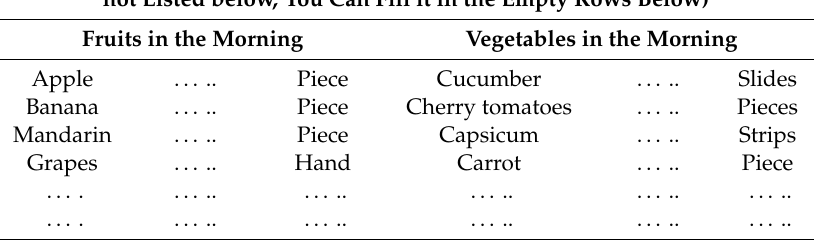
Table 2. One of the precoded questions on FV intake in the 24 h recall. Did you Eat Fruit or Vegetables Yesterday Morning? (Write Yes / No) If Yes, What Kind of Fruit or Vegetable and How Much? (Write 1 if You Ate One Apple, Write Half if You Ate Half an Apple. If Your Fruit or Vegetable